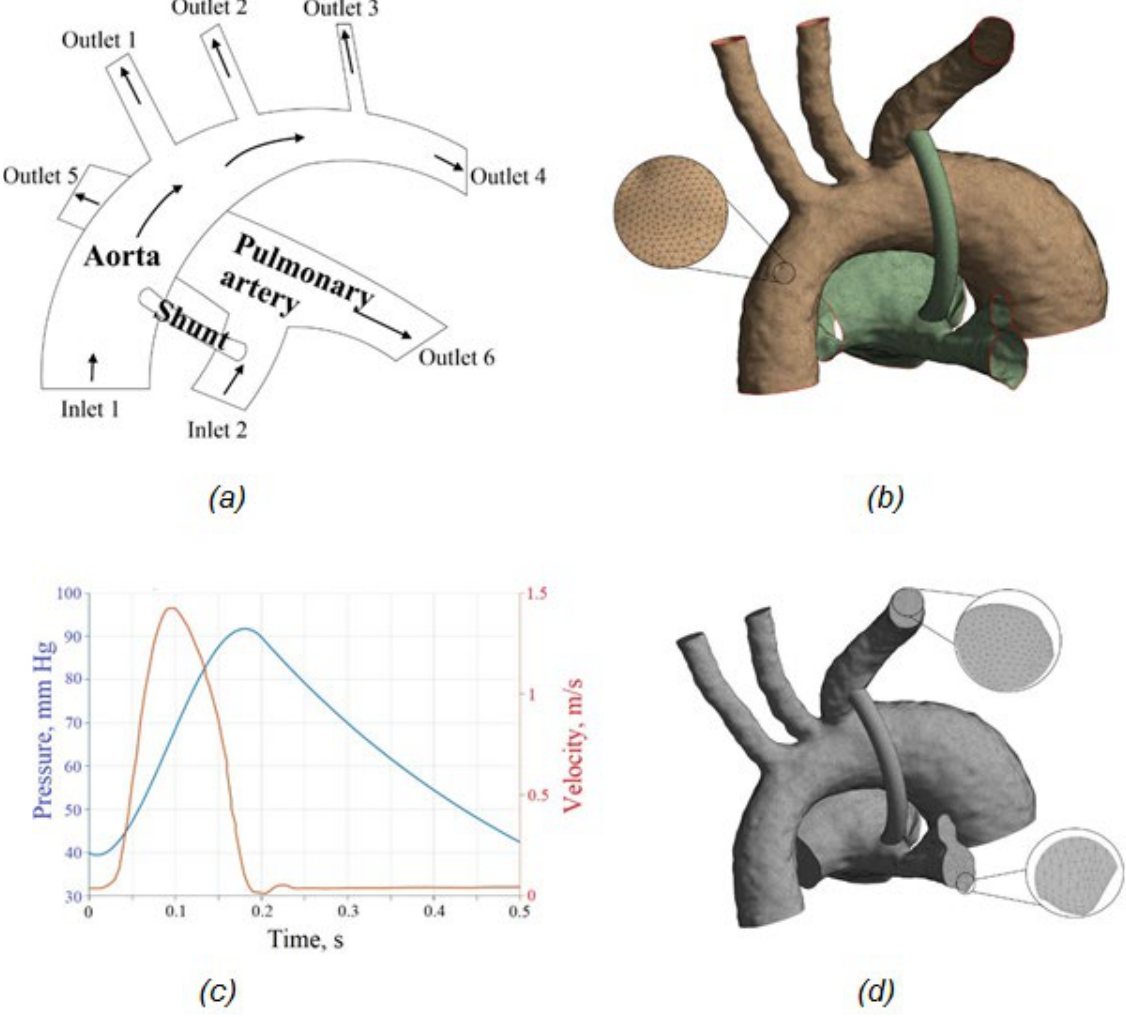
Figure 1. Meshes and boundary conditions of the aorta–shunt–pulmonary artery system: ( a ) bound- ary conditions, ( b ) solid mesh, ( c ) velocity and pressure profiles, ( d ) aorta fluid mesh model.